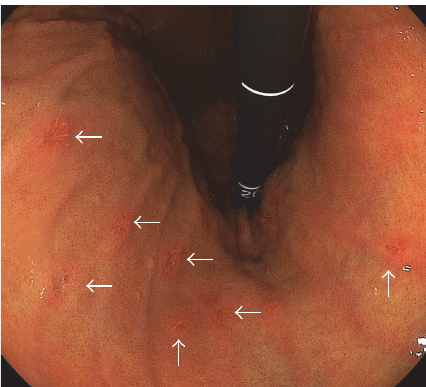
Figure 4: Multiple recurrence was documented at 40 months after the endoscopic